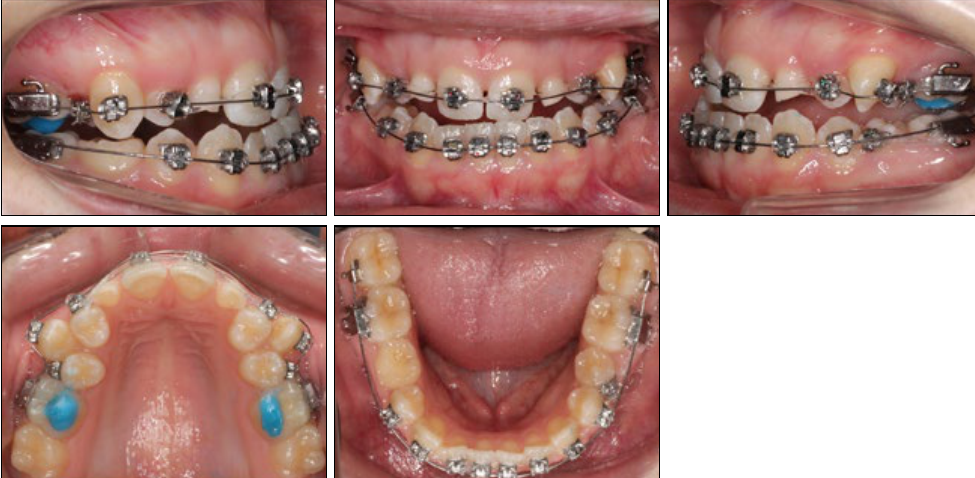
Figure 6. Treatment progress intraoral photographs. First treatment stage.